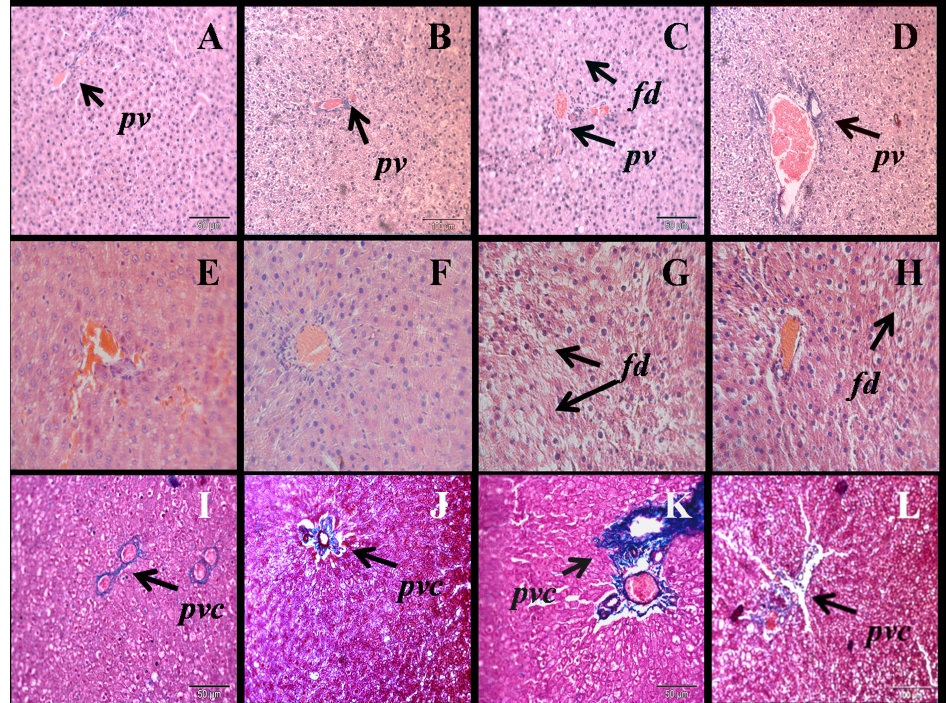
Figure 4. Haematoxylin and eosin staining of liver (×20) showing fat deposition in C ( A ), CN ( B ) H ( C ), HN ( D ) rats ( fd , fat droplets; pv, portal vein (upper panel)) and ×40 for C ( E ), CN ( F ) H ( G ), HN ( H ) rats (middle panel). Milligan’s trichrome staining of the